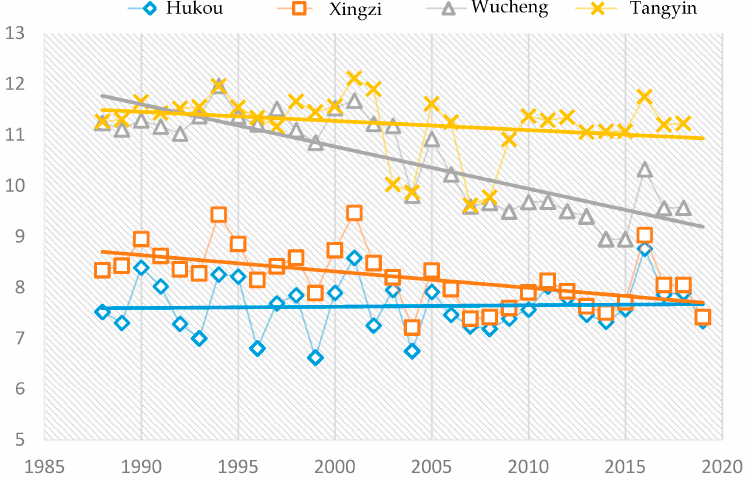
Figure 9. Variation of all the previous annual water levels with a 98% guarantee rate of duration at the main hydrometric stations in the Poyang Lake area.